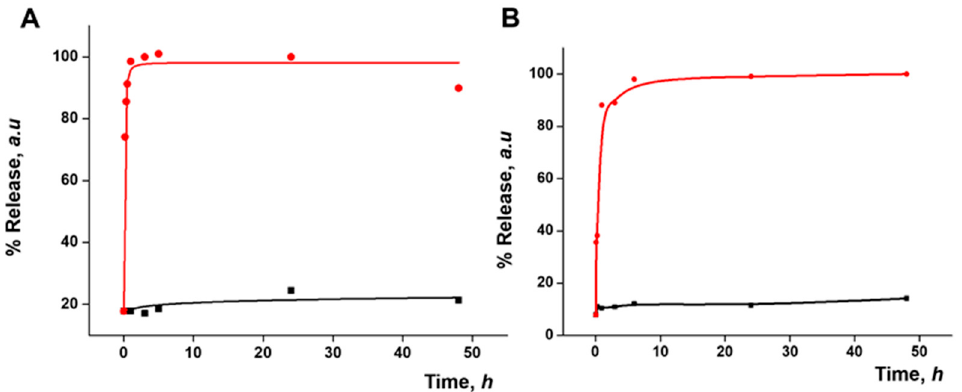
Figure 3. Kinetic release profile of safranin O delivered from S2 ( A ) or of DOX delivered from S3 ( B ) in water in the absence (black) and in the presence (red) of GSH (10 mM).